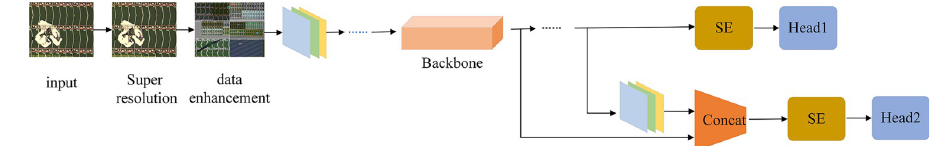
Fig 6. Double T-head structure, in addition to head1, head2 is also designed to enhance the detection of small target defects.